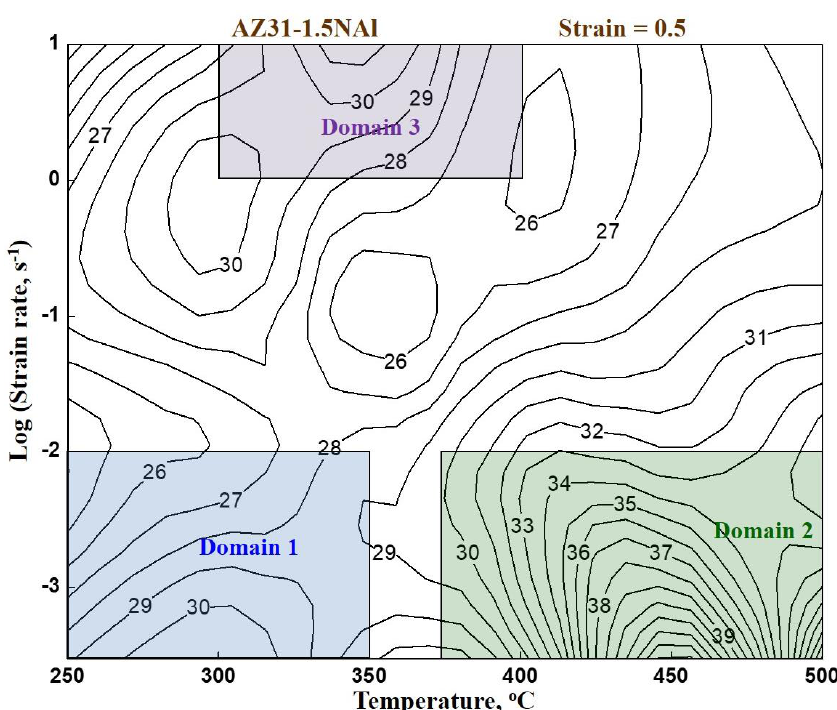
Figure 3. Processing map for DMD-processed AZ31-1.5NAl composite at a strain of 0.5. The numbers associated with the contours indicate efficiency of power dissipation in percent. Reproduced with permission from [13], Elsevier, 2014.